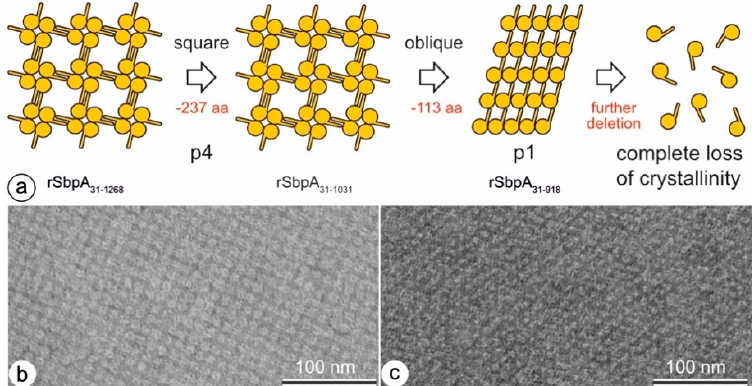
Figure 10. ( a ) Schematic drawing of the transformation of the SbpA S-layer lattice symmetry from square to oblique, and finally, the complete loss of crystallinity; ( b ) TEM image of the rSbpA 31–1268 lattice showing square (p4), and ( c ) of the rSbpA 31–918 lattice exhibiting oblique (p1) lattice symmetry [93] (reproduced with permission from Reference [36]; published by MDPI AG, 2013).